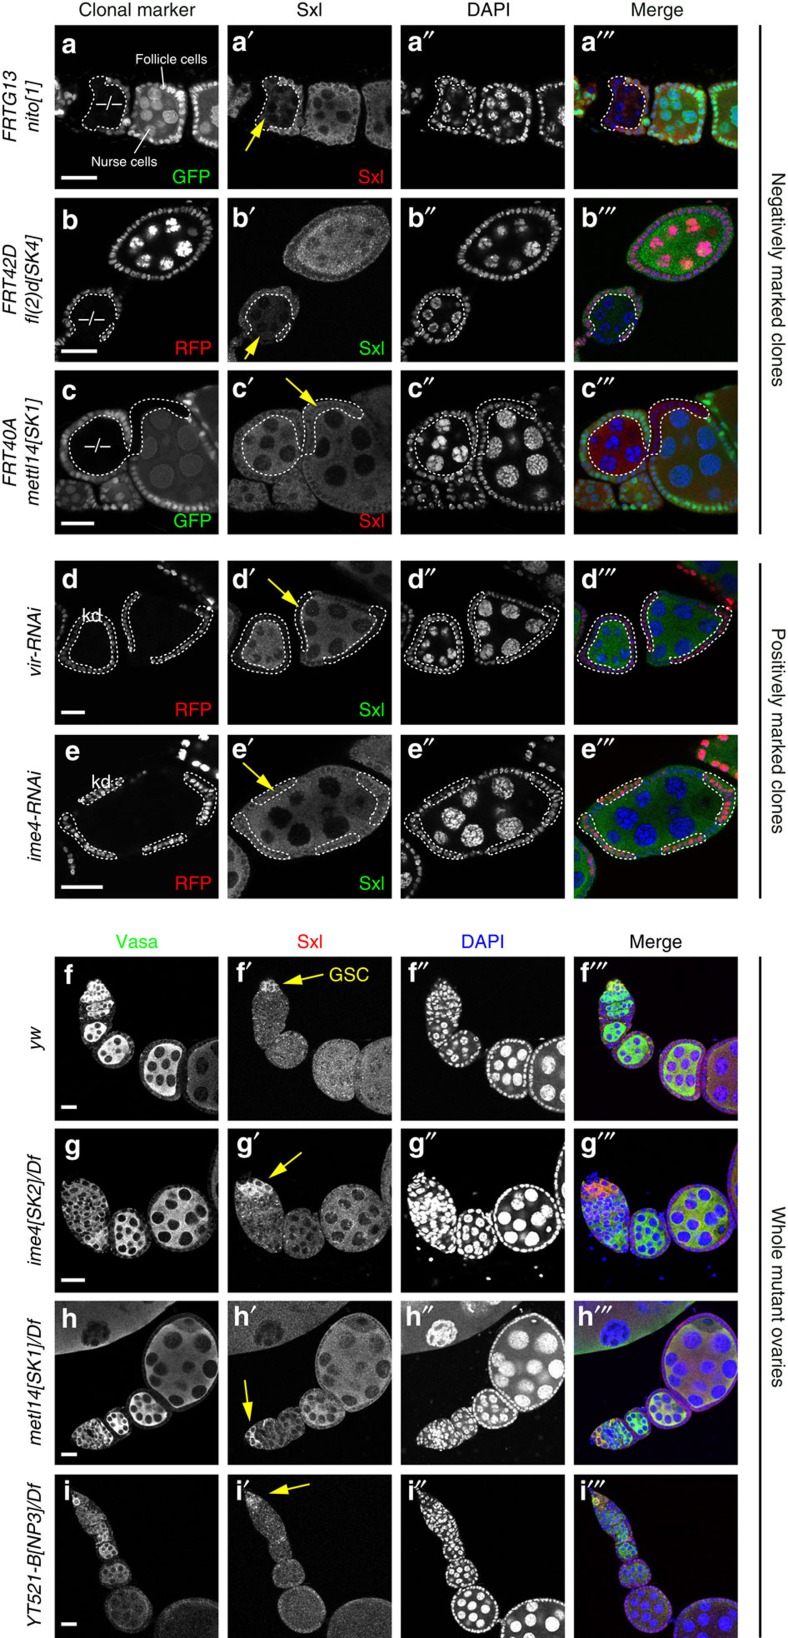
Selective requirement for classical, but not core, m6A factors for Sxl accumulation in ovaries.Shown are midstage egg chambers that permit comparison of somatic (follicle cells) and germline (nurse cells and/or oocyte) expression of Sxl protein. (a–c) Negatively marked mitotic clones, for which homozygous mutant cells lack either GFP or RFP (dotted clones). Sxl protein is clearly reduced in nito[1] (a') and fl(2)d[SK4] (b') clones (yellow arrows), but is maintained in mettl14[SK1] clones (c′). (d,e) Positively marked knockdown clones generated in somatic cells. Cells expressing the indicated RNAi transgene are labelled by RFP. Sxl protein is clearly reduced in vir-RNAi clones (d′) but not in ime4-RNAi clones (e′). (f–i) Control and mutant ovaries stained for Sxl and the germline marker Vasa. In these non-clonal settings, it is difficult to discern changes in marker protein levels as with clonal experiments. Therefore, these images include the germarium, where elevated levels of Sxl are evident in germline stem cells (GSCs). Overall normal staining patterns of Sxl and Vasa in yw control (f) are maintained in ime4 (g), mettl14 (h) and YT521-B (i) hemizygous ovaries. Scale bars, 20 μm.